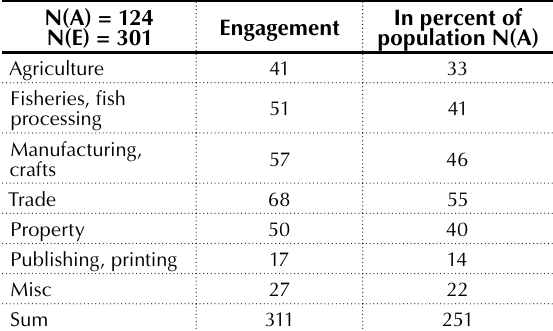
Table 3. Haugean entrepreneurs by industrial